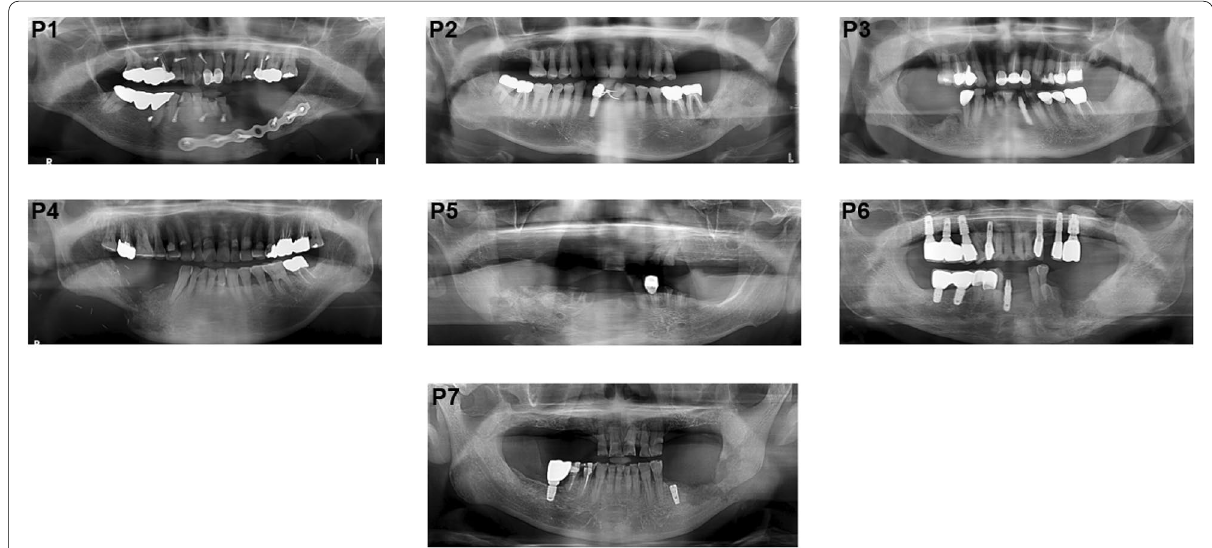
Fig. 1 Preoperative orthopantomogram X‑rays of the